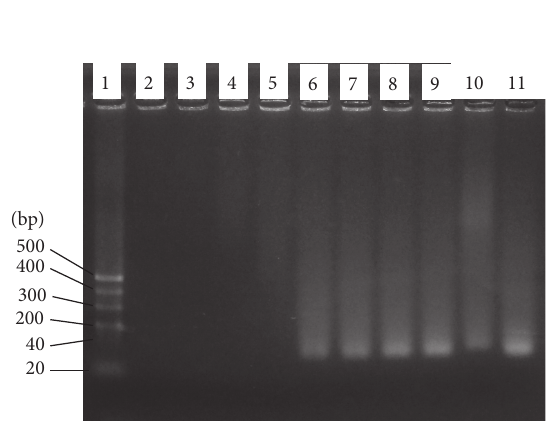
Figure 1: The release of siRNA from DOPC/DOPE liposomes treated with curcumin. DOPC/DOPE liposomes containing siRNA were treated with curcumin in a sample volume of 10 𝜇 l at room temperature for 30min, and then the resultant sample was applied for 2% agarose gel electrophoresis. After the electrophoresis, siRNA was detected by means of EtBr staining. Lanes 1–3: 1, DNA marker with length (bp) indicated at the left side; 2, untreated liposomes; 3, DMSO-treated liposomes. Lanes 4–10: liposomes treated with curcumin at 0.25, 0.3, 0.4, 0.5, 0.6, and 0.7 𝜇 g/ml, respectively. Lane 11: Triton X-100-treated